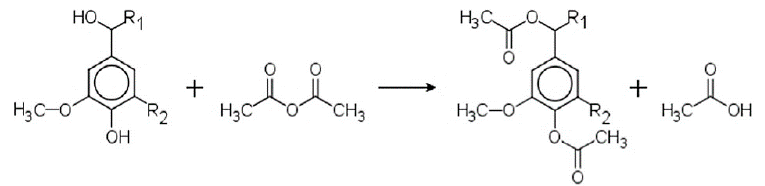
Figure 9. Esterification of lignin by acetic anhydride [68].